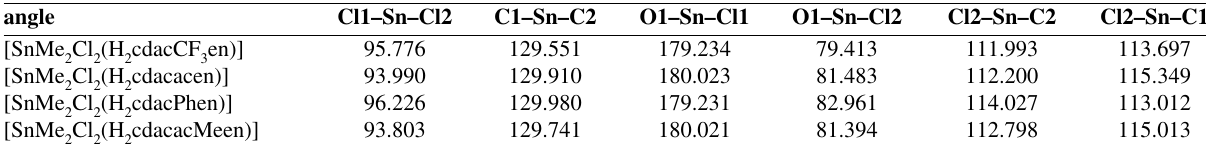
Table 6. The selected bond angles (°) of Sn(IV) complexes (labels for atoms can be found in Figures 3 and S1) angle